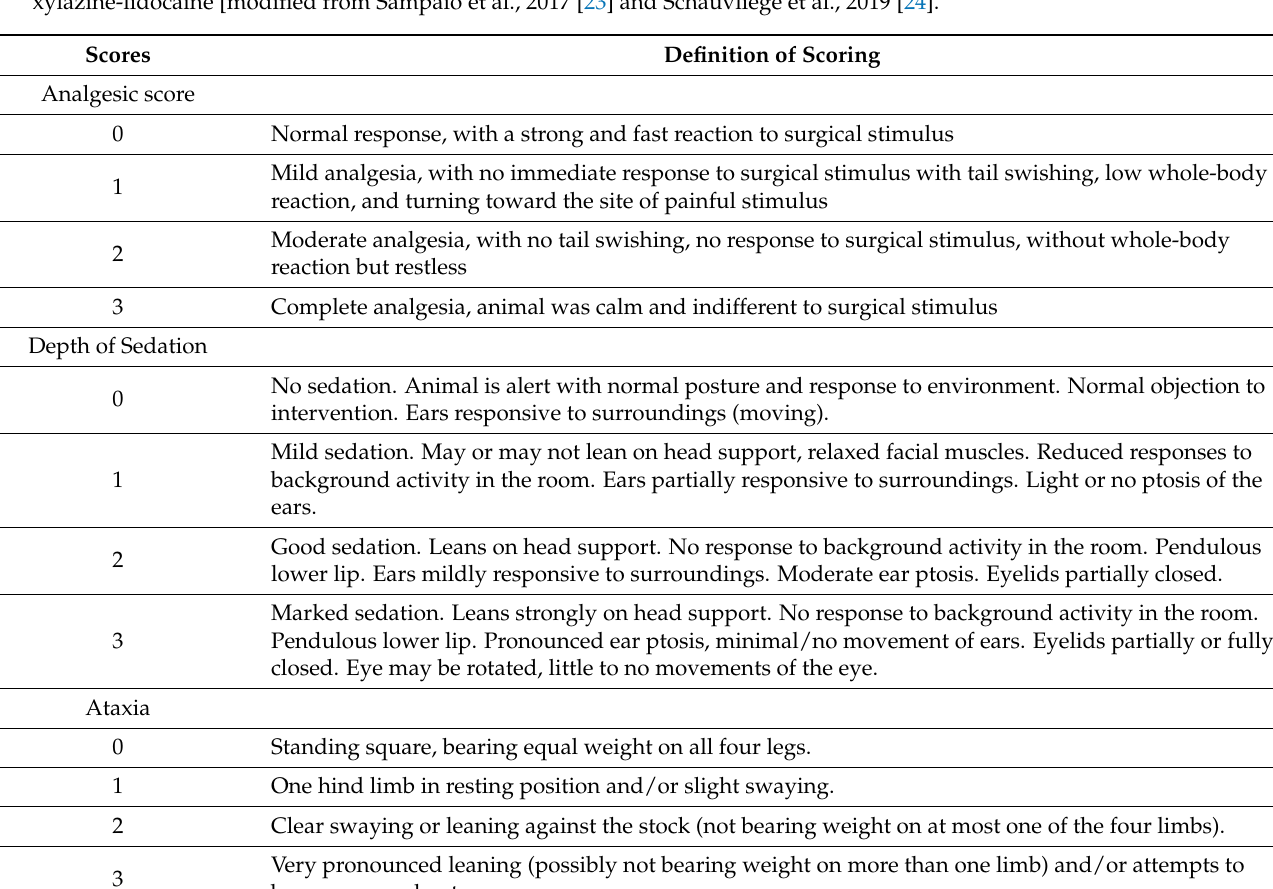
Table 2. Scoring system used to score analgesia, depth of sedation, and ataxia in 8 mules undergoing ovariectomy under acepromazine, xylazine and butorphanol sedation followed by a CRI of xylazine combined with epidural anaesthesia with xylazine-lidocaine [modified from Sampaio et al., 2017 [23] and Schauvliege et al., 2019